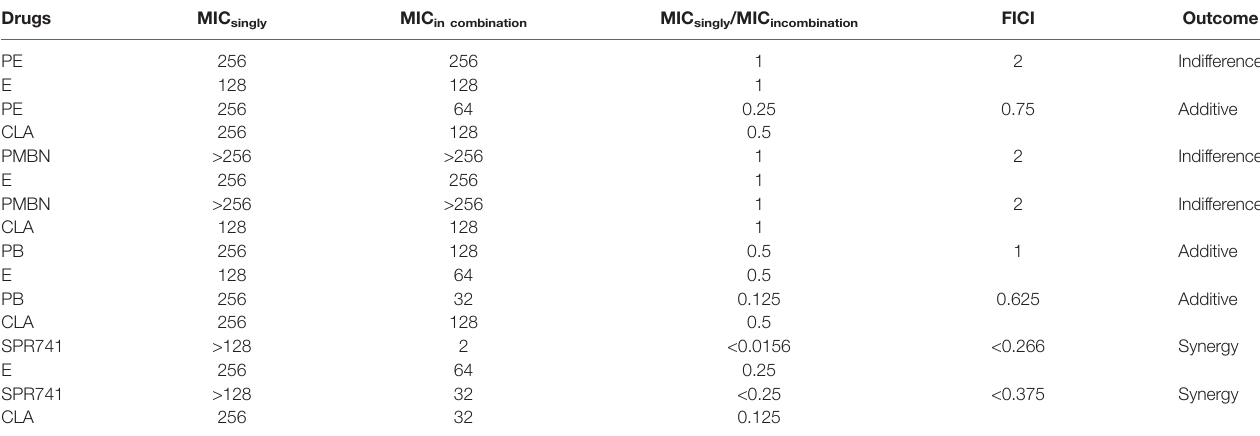
TABLE 2 | Antibiotics combination against PDR K. pneumoniae